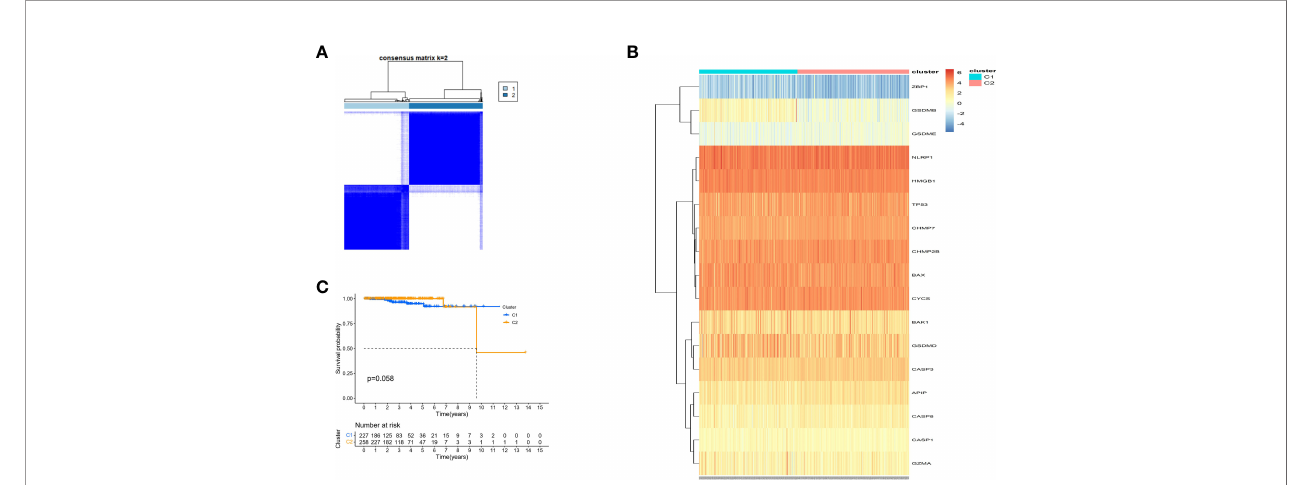
FIGURE 6 | Tumour classi fi cation based on the pyroptosis-related DEGs. (A) 485 PC patients were grouped into two clusters according to the consensus clustering matrix (k=2). (B) Heatmap and the clinicopathologic characters of the two clusters classi fi ed by these DEPRGs. (C) Kaplan-Meier OS curves for the two clusters.